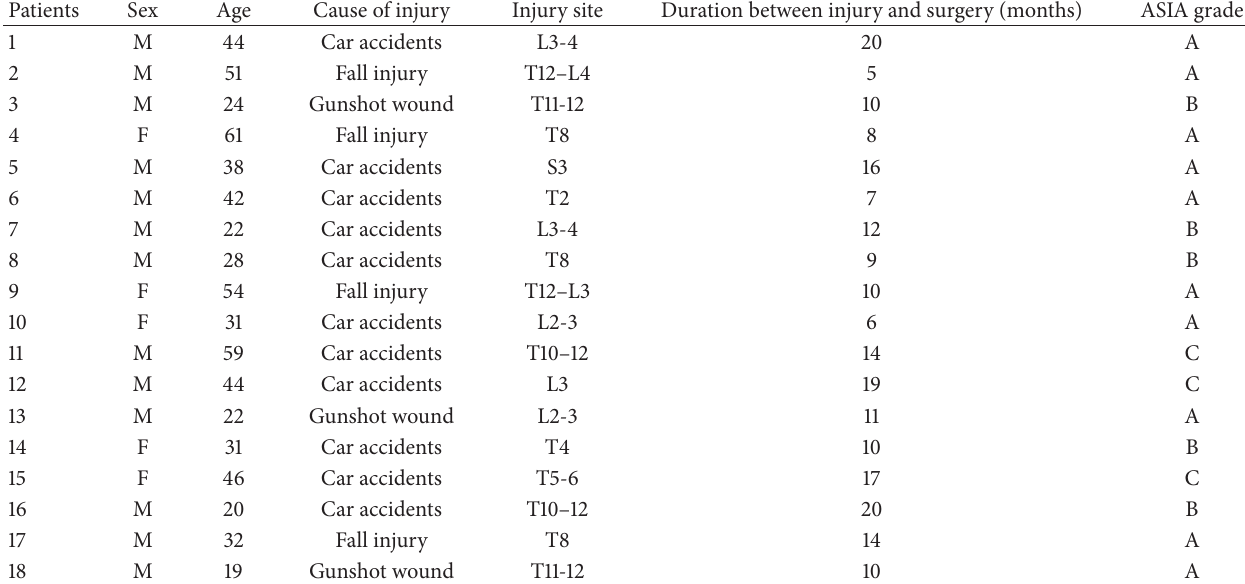
Table 2: Patient